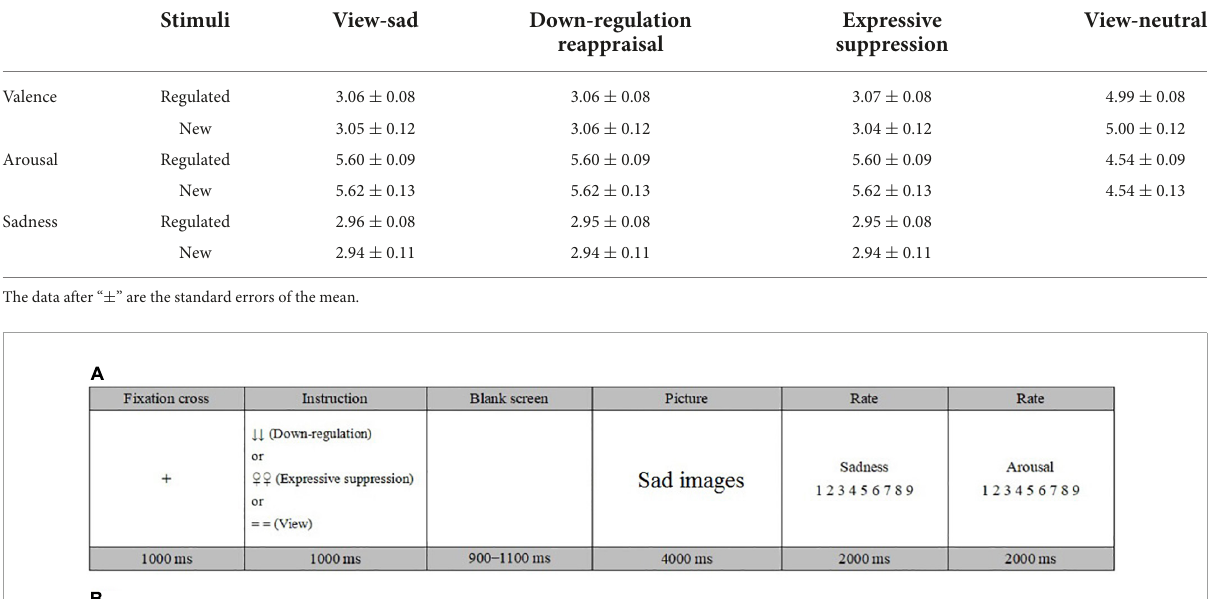
TABLE 1 The average valence, sadness, and arousal ratings of the stimuli groups in this study.